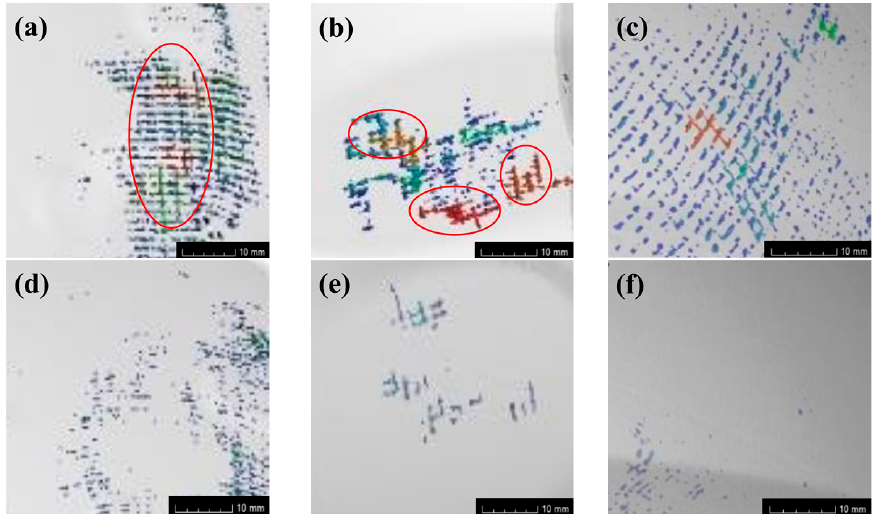
Figure 5. Micro-CT internal voids detection:( a – c ) defects of samples prepared by RTM process; ( d – f ) internal defects of samples prepared by M-CRTM process.